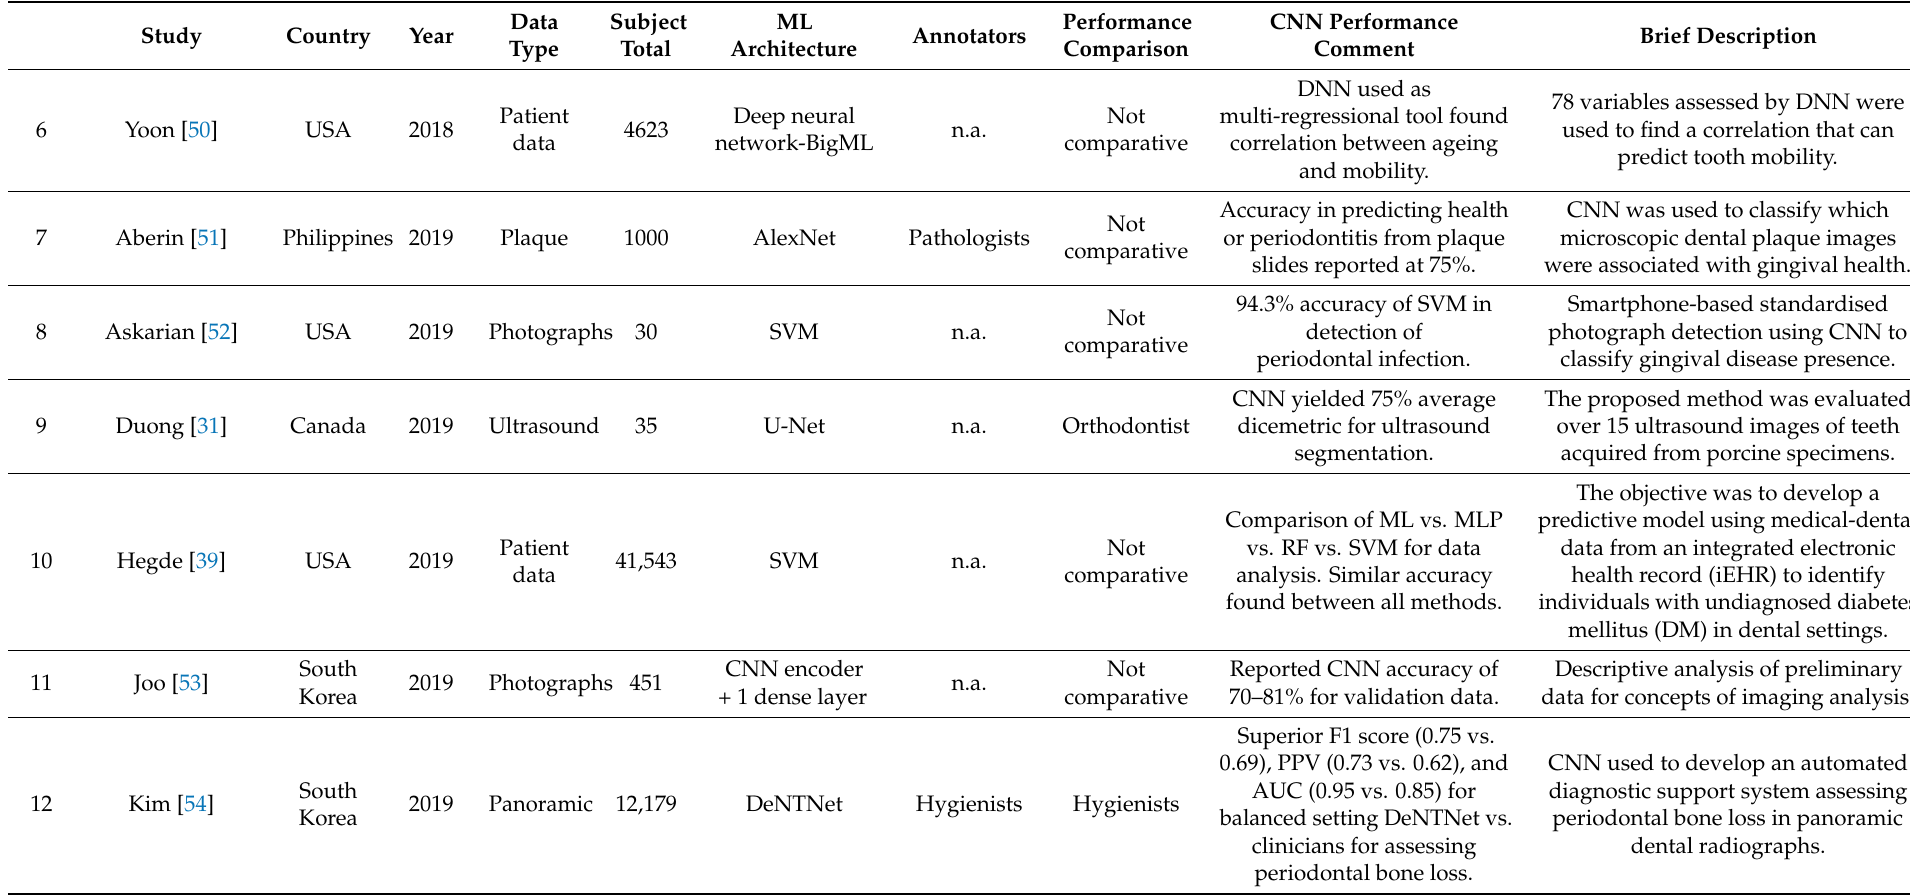
vs. RF vs. SVM for